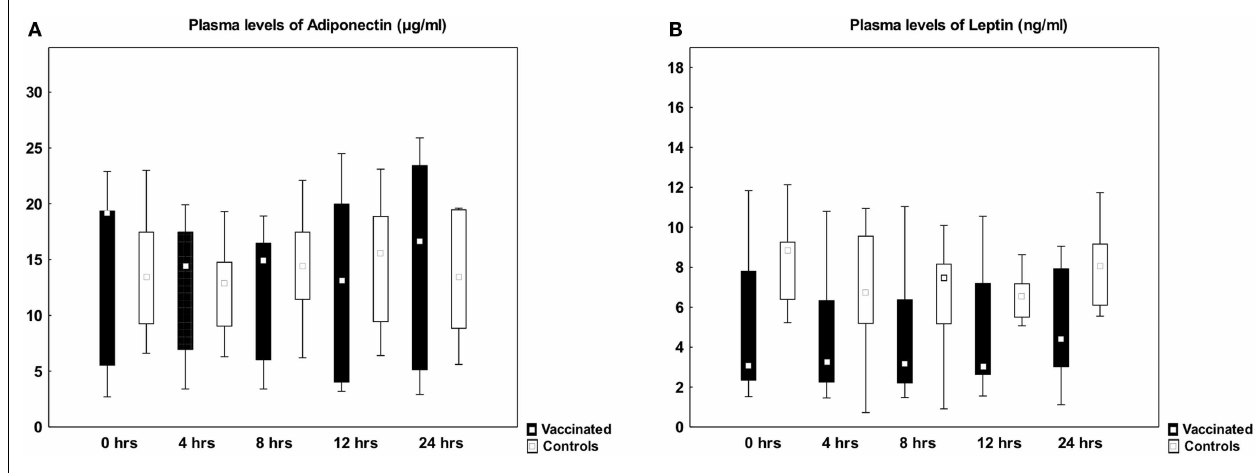
controls ( n = 9, open boxes).There was no difference between the two groups using mixed linear models. Median, box: 25–75%, whiskers: non-outlier